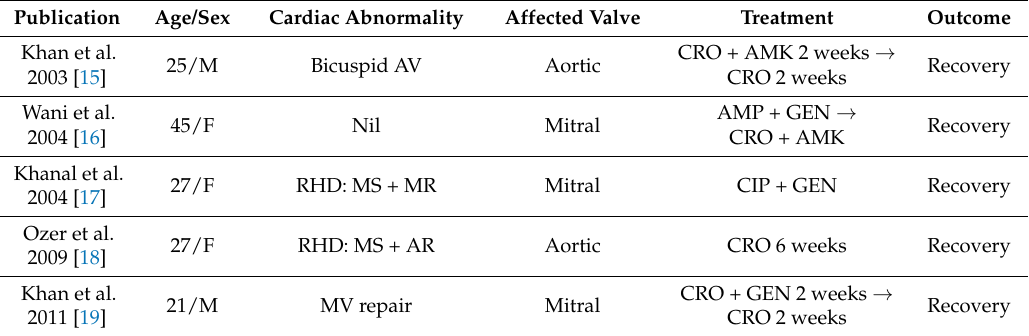
Table 1. Cases of Salmonella enteric serovar Typhi infective endocarditis in the English literature